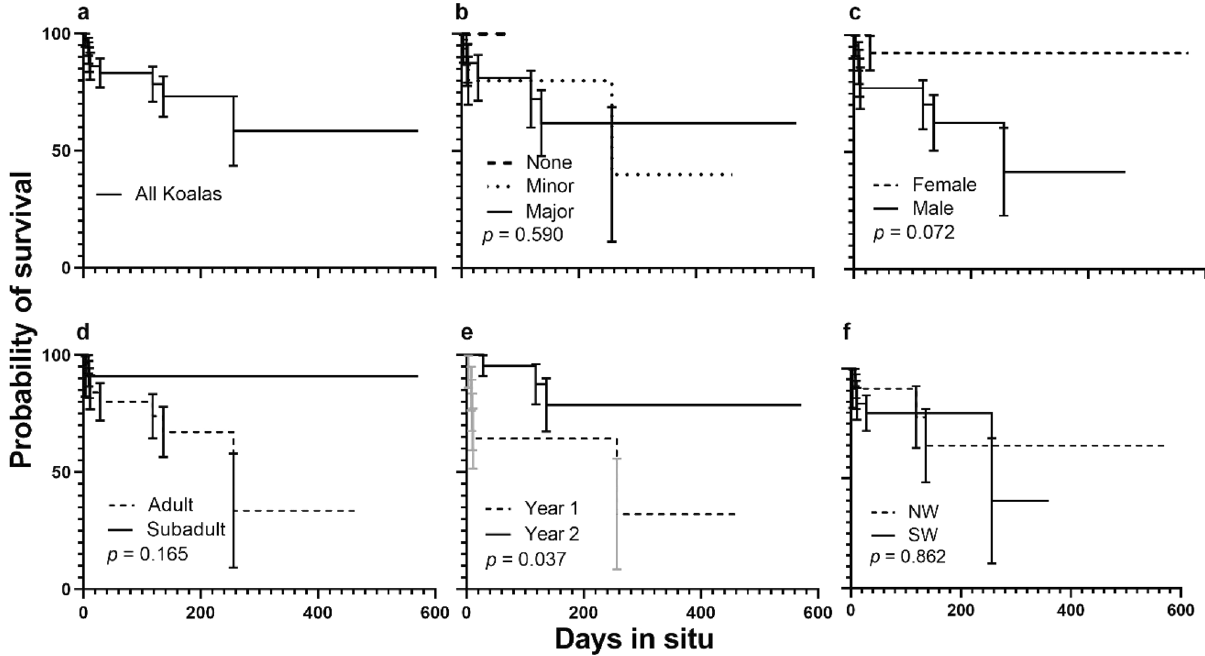
Figure 5. Kaplan Meier survival probability curves for long-term survival for ( a ) all koalas, ( b ) considering medical intervention (none, major, minor), ( c ) sex (female, male), ( d ) age (adult, subadult), ( e ) study year (year 1, year 2), and ( f ) region (northwest [NW], southwest